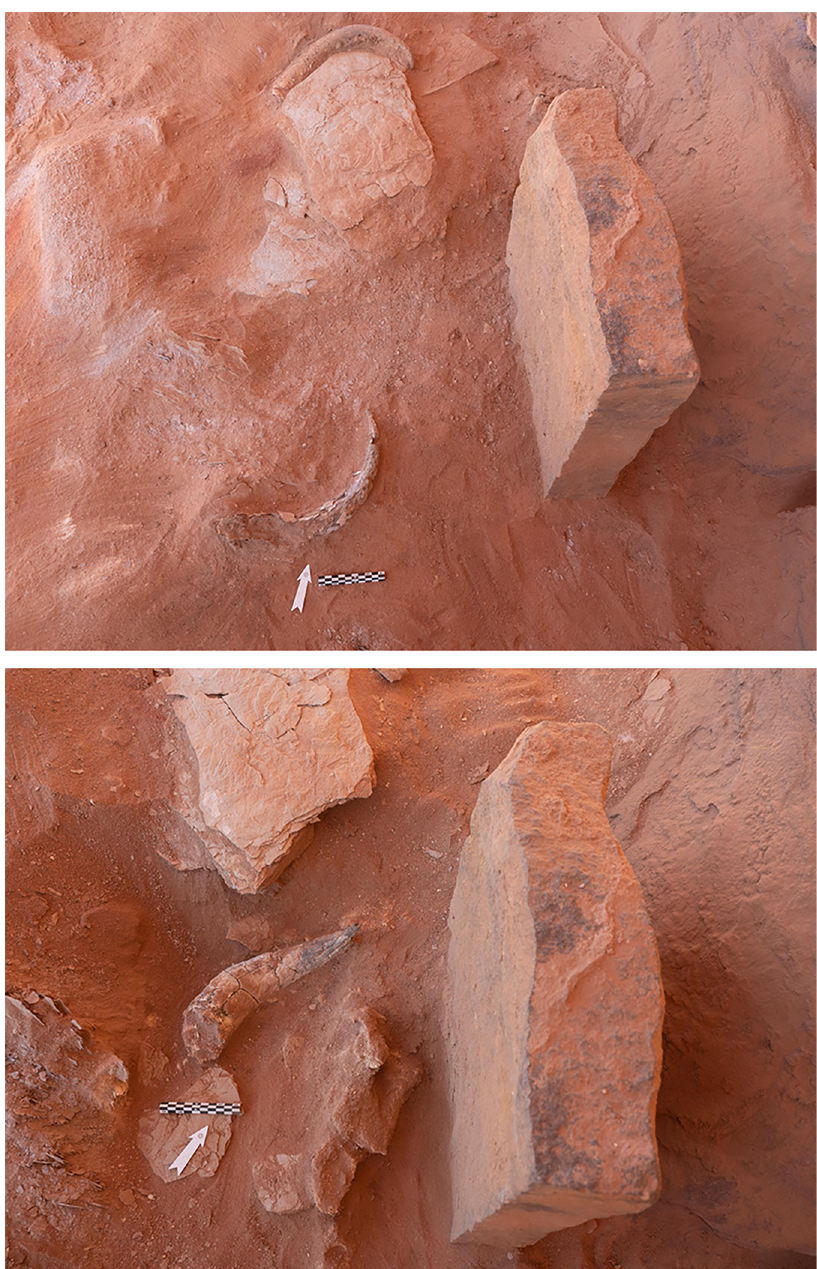
Fig 11. Cattle horns found in association with the betyl in Phase 3 (10 cm depth between the two images). Top image (#0034 –top) and (#0039 –bottom). Bottom image (#0037). the same level together, 40 cm from stone A, and #0045). A Bos sp. maxillary was found upside down, lying on a collapsed oblique stone. This phase was then sealed by 15-20cm of sand and porary with the initial presence of these remains, as suggested by taphonomy and the radiocar- bon data. Similarities between sheaths #0037 and #0039 belonging to distinct phases (Phases 3A and 3B), and distinct taphonomy on sheaths from the same context (cattle sheaths #0037